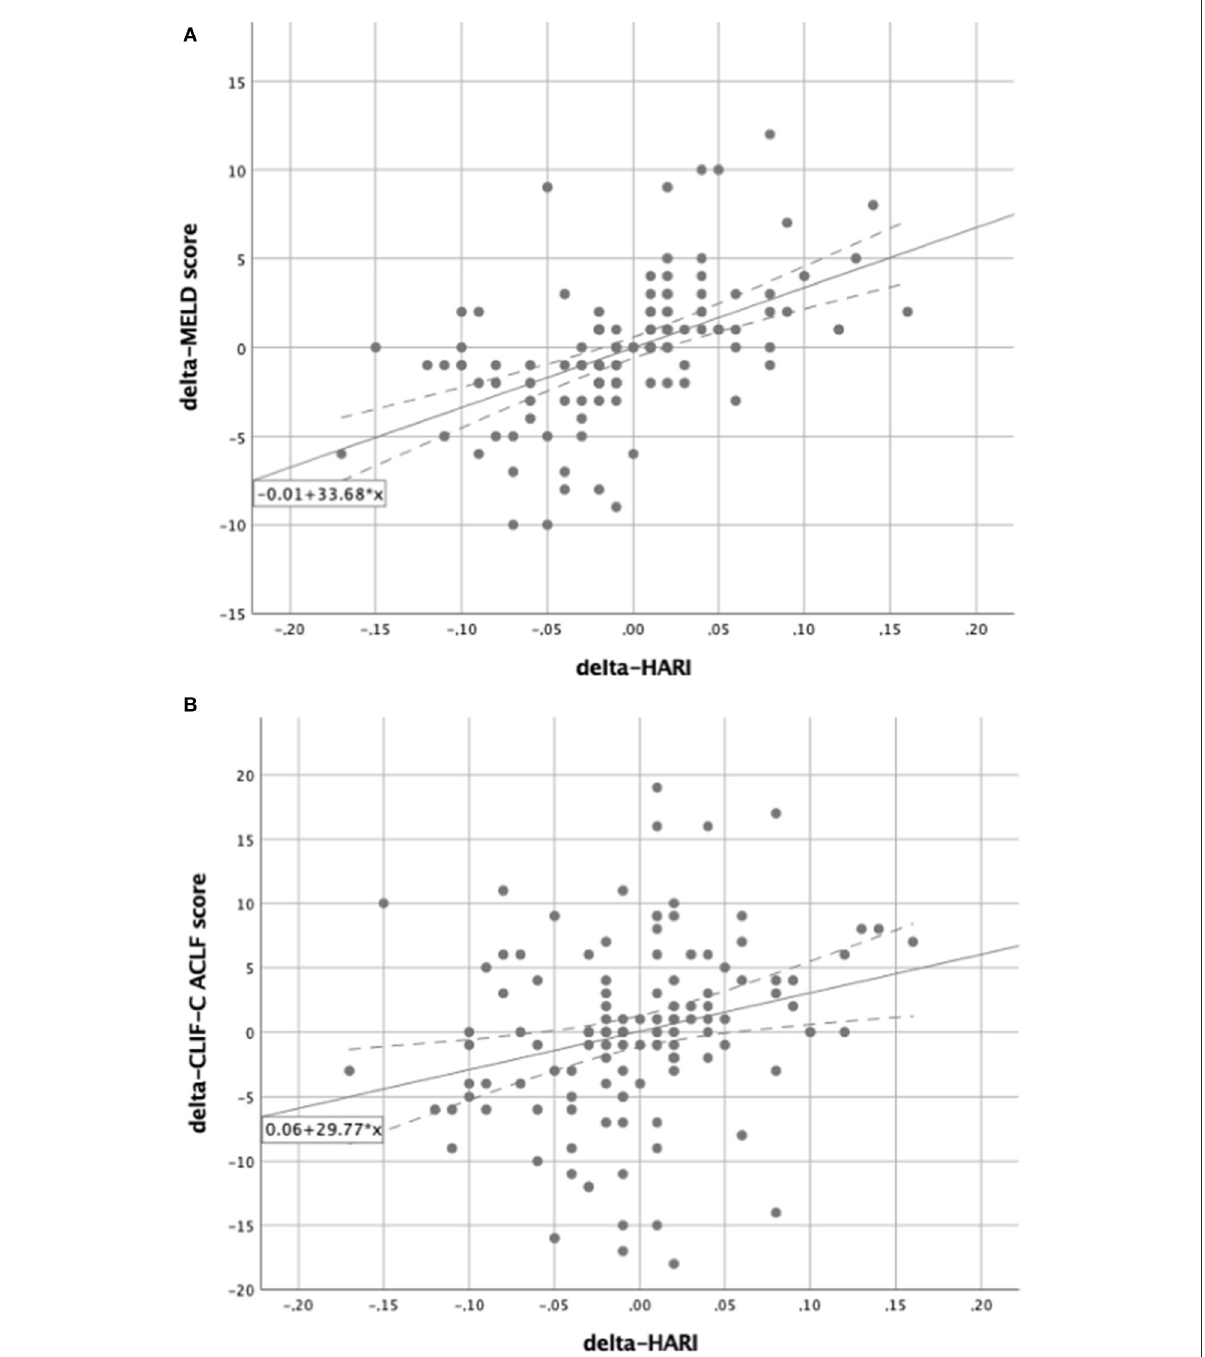
FIGURE6 Subgroup analysis for patients with liver cirrhosis. Scatter plots for the correlation between delta-HARI and delta-MELD or delta-CLIF-C ACLF score for patients with liver cirrhosis. (A) Showing a positive linear correlation between delta-HARI and delta-MELD score. (B) showing a positive linear correlation between delta-HARI and delta-CLIF-C ACLF